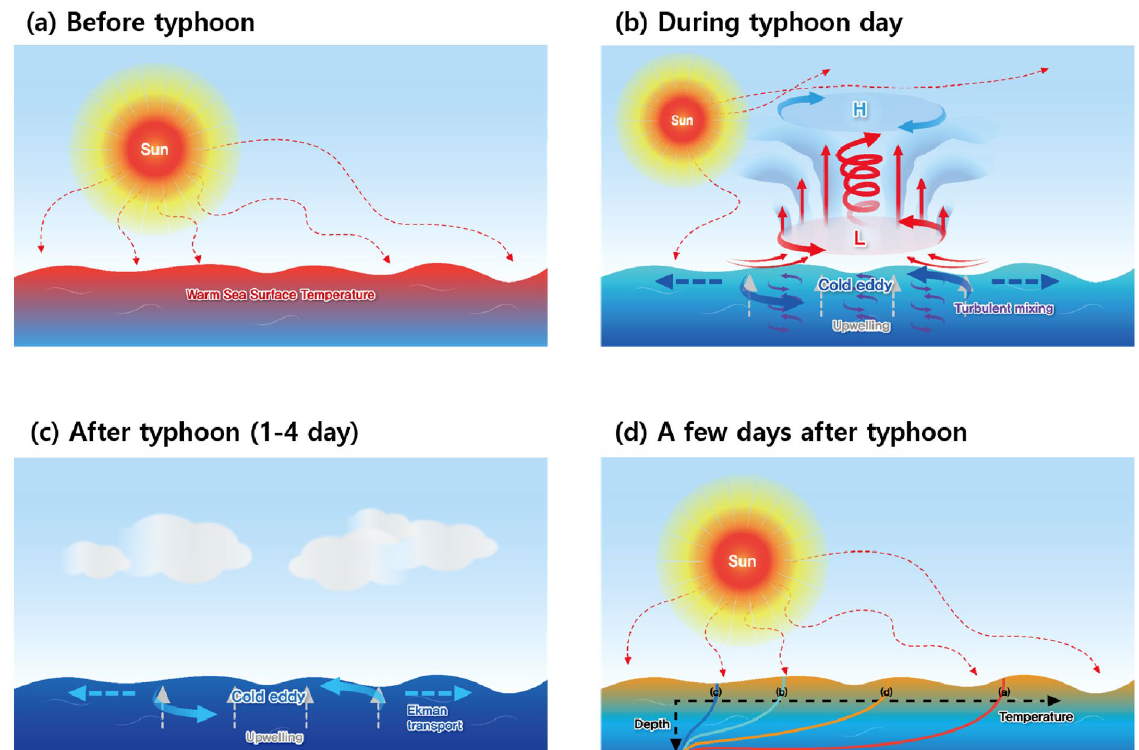
Figure 4. Schematics of physical processes of ocean temperature change before typhoon ( a ), during typhoon affecting day ( b ), after typhoon ( c ), and a few days after typhoon arrival ( d ). Vertical temperature profiles in each time step are shown in ( d